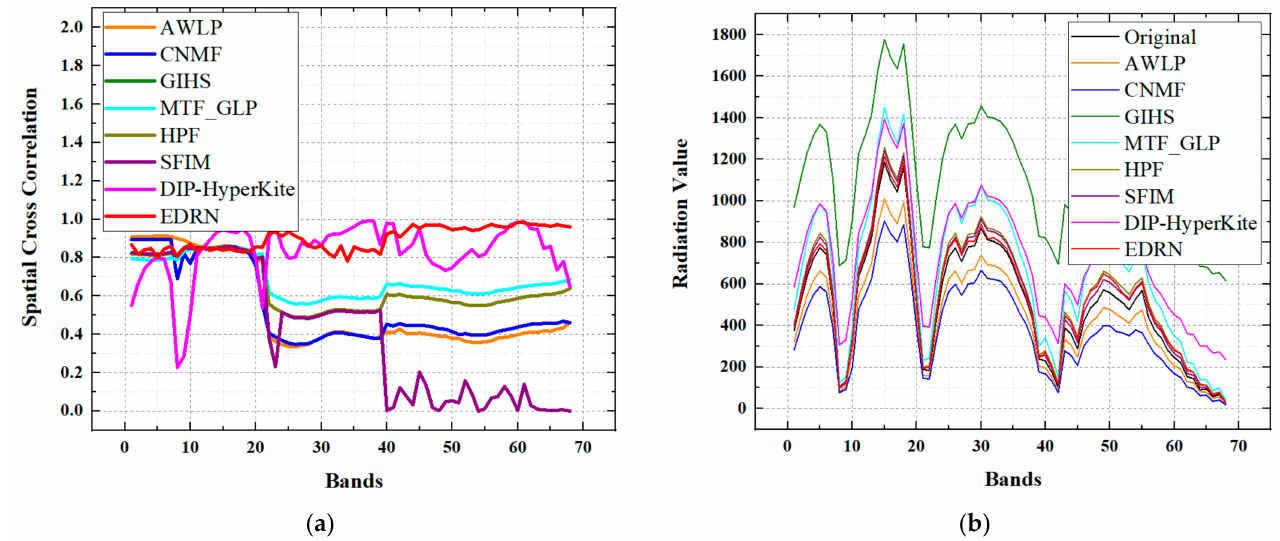
Figure 16. Quality of the compared and proposed fusion methods on the Baiyangdian dataset: ( a ) SCC; ( b ) spectral curve comparison. Table 1. Quality of the compared and proposed fusion methods on the Baiyangdian dataset for RMSE, SAM, PSNR, SSIM, ERGAS and the Q metric. Method RMSE SAM PSNR